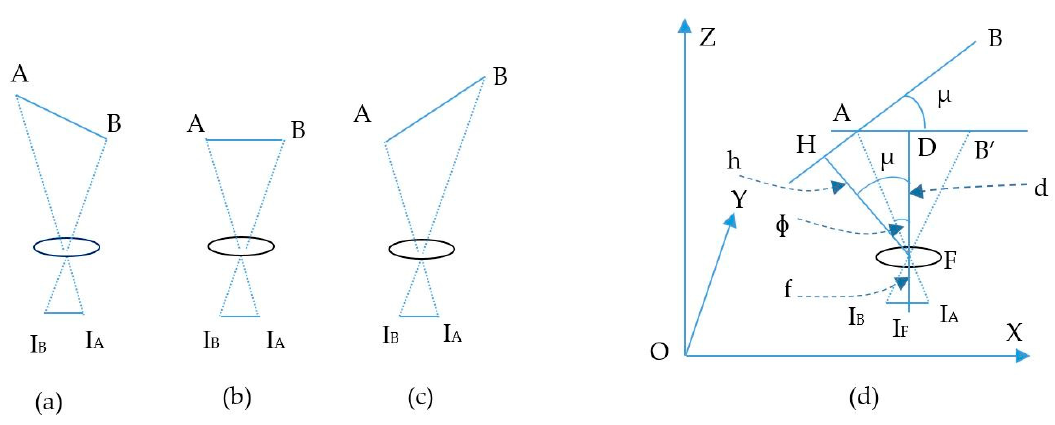
Figure 2. Distance-estimation-based photography technique.